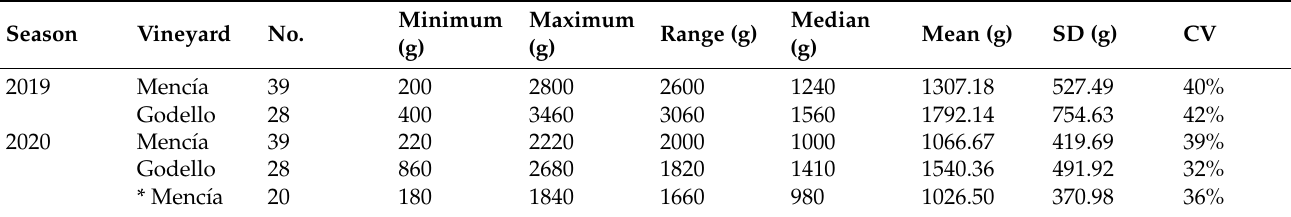
Table 2. Pruning weight